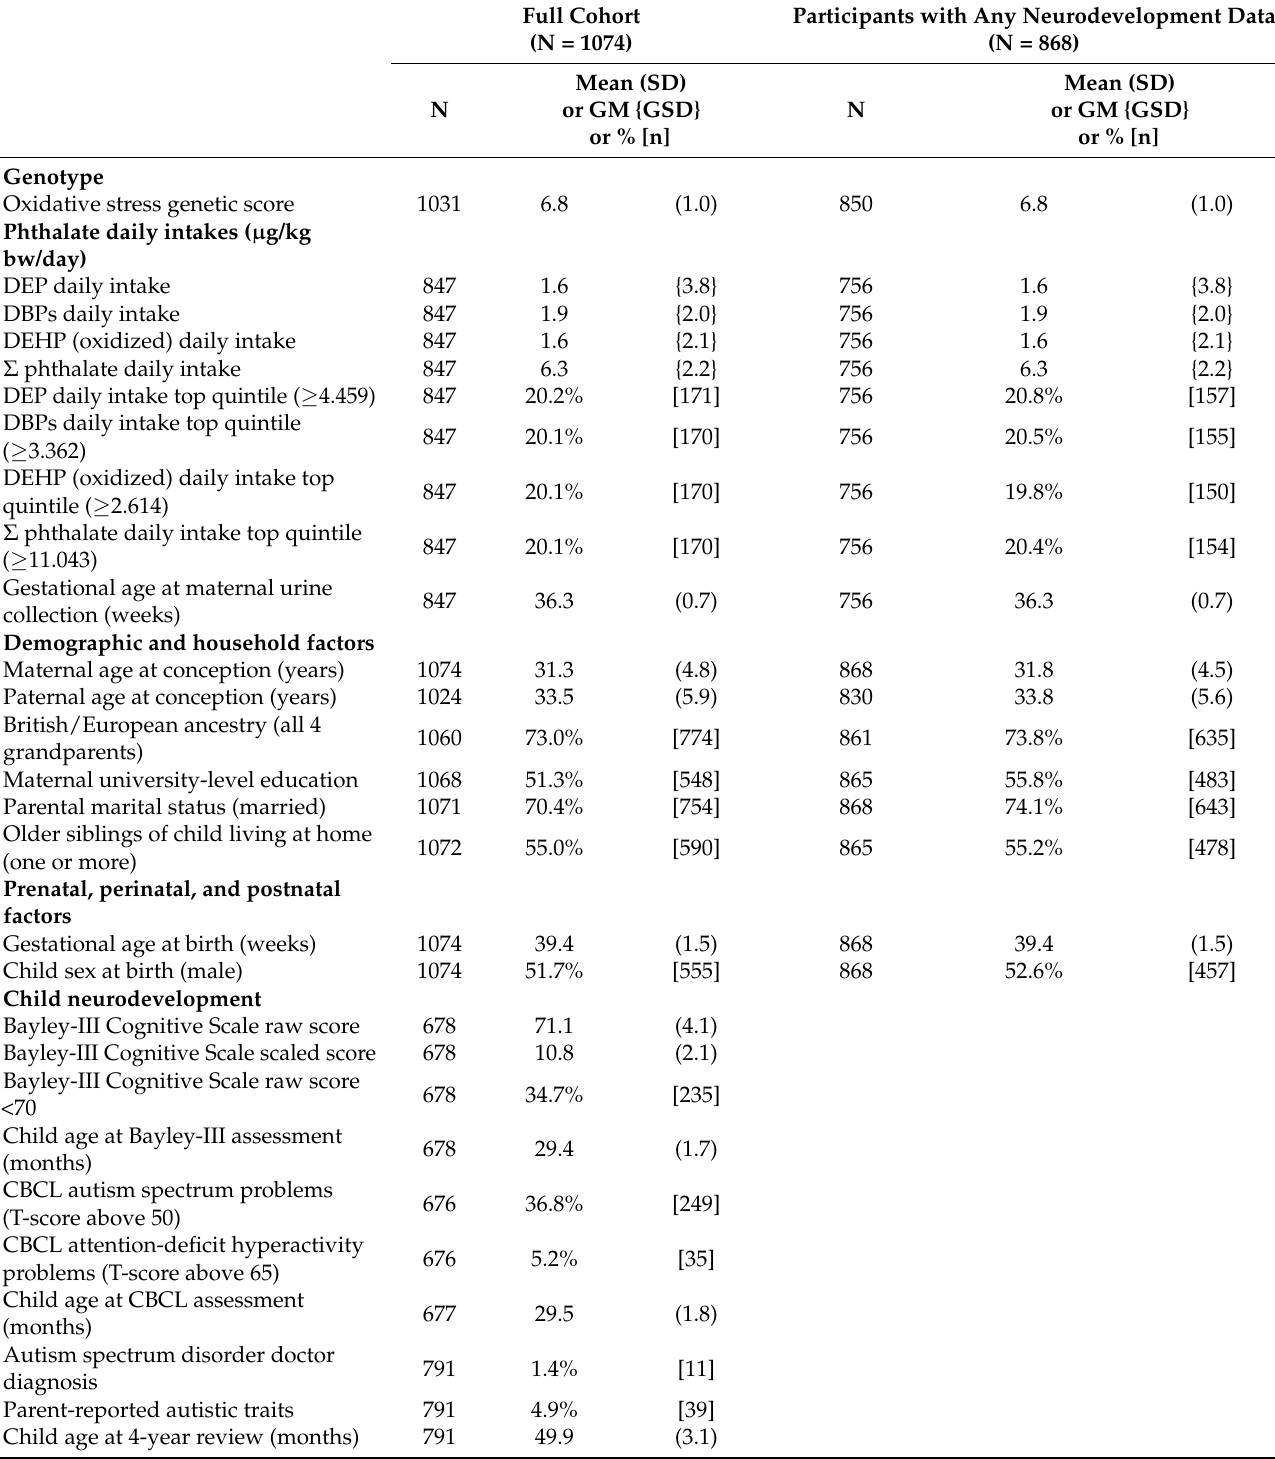
Table 2. The distribution of key characteristics in the Barwon Infant